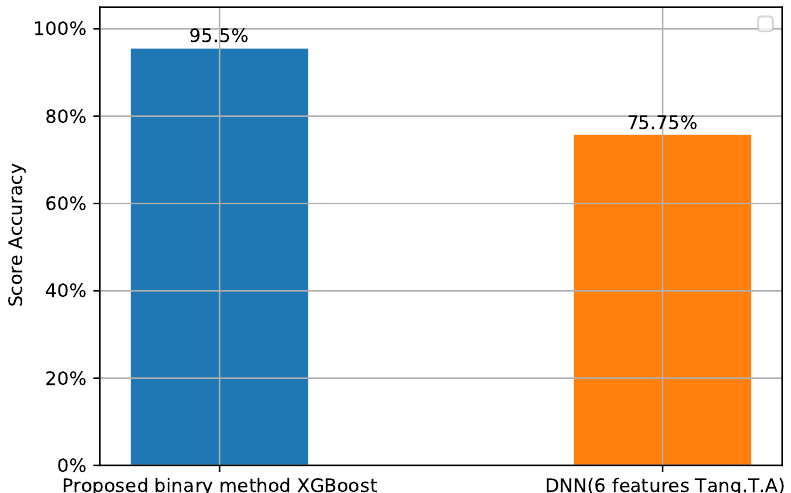
Figure 6. Accuracy score is measured in order to evaluate the performance of the proposed XGBoost model against the Deep Neural Networks